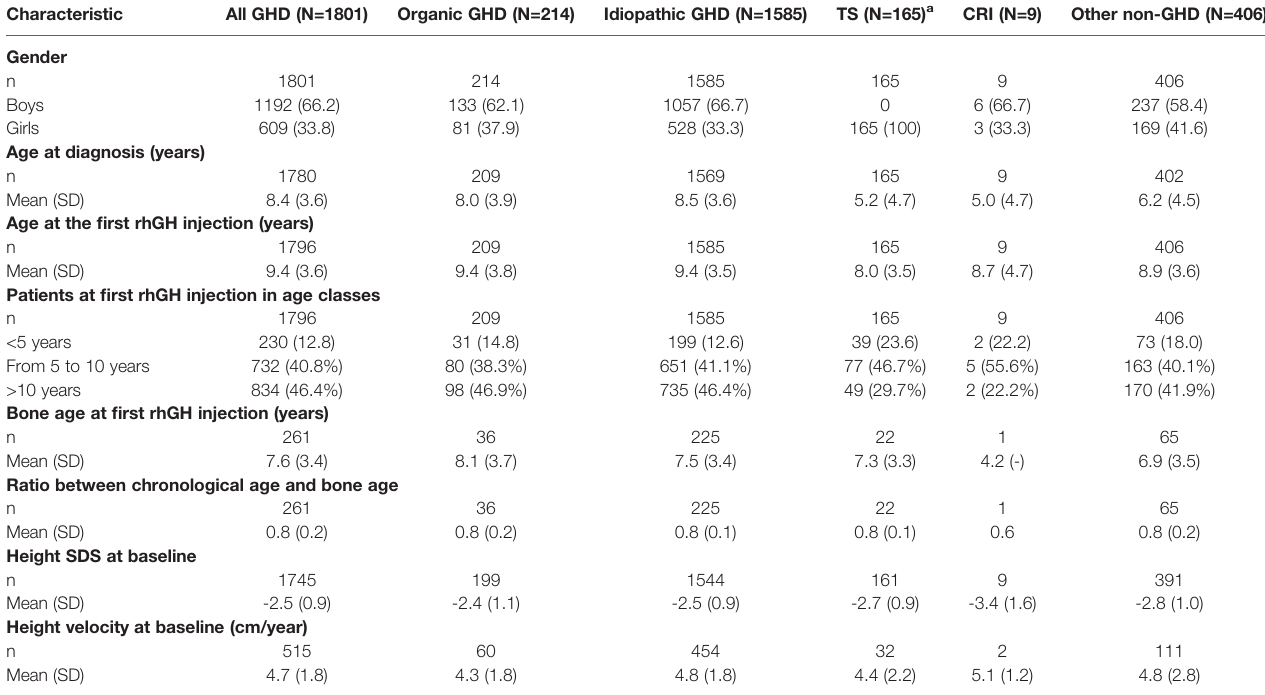
TABLE 1 | Baseline characteristics – Enrolled population treatment naïve.